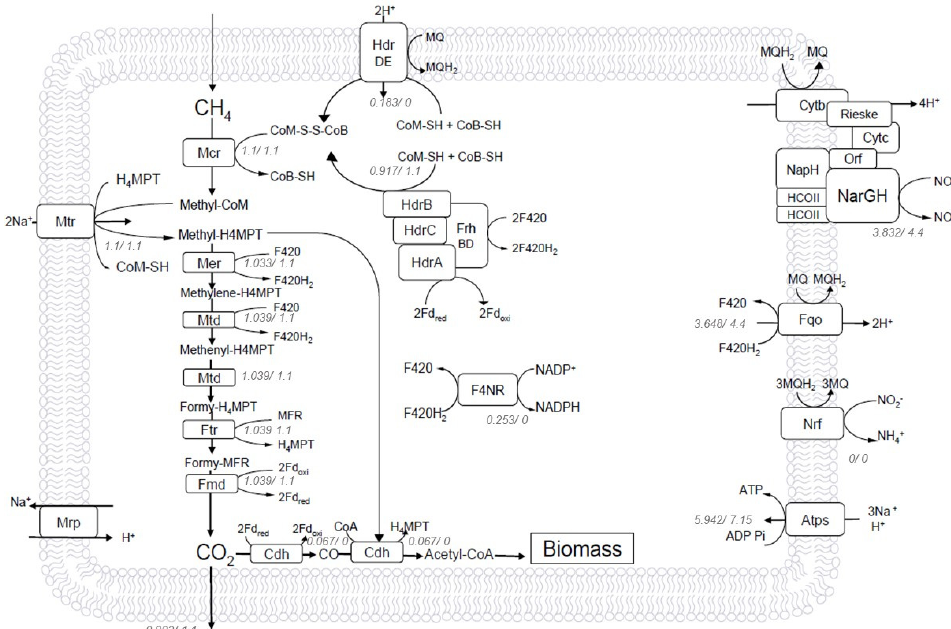
Figure 2. Reverse methanogenesis pathway supported by the model i MN22HE of M. nitroreducens . As shown, methane is the only carbon source. Through the reverse methanogenesis pathway, most of it is oxidized to carbon dioxide, with a small amount of carbon flux through the reductive acetyl-CoA pathway to generate acetyl-CoA for cell growth. Numbers in italics next to enzymes denote reaction fluxes (mmol gDW − 1 h − 1 ) calculated under biomass ( left ) and ATP ( right ) maximum. Nitrate is the terminal electron acceptor, reduced by the NarGH-Rieske/cytochrome b complex, which drives the reverse methanogenesis in M. nitroreducens . Mcr, methyl-coenzyme M reductase, HdrABC, soluble F420-dependent heterodisulfide reductase, Mtr, methyl-H4MPT: coenzyme M methyltransferase, Cdh, CO dehydrogenase, Fqo, membrane-bound F420H2: quinone oxidoreductase, Nrf, nitrite reductase, F4NR, F420-dependent NADP reduc- tase.